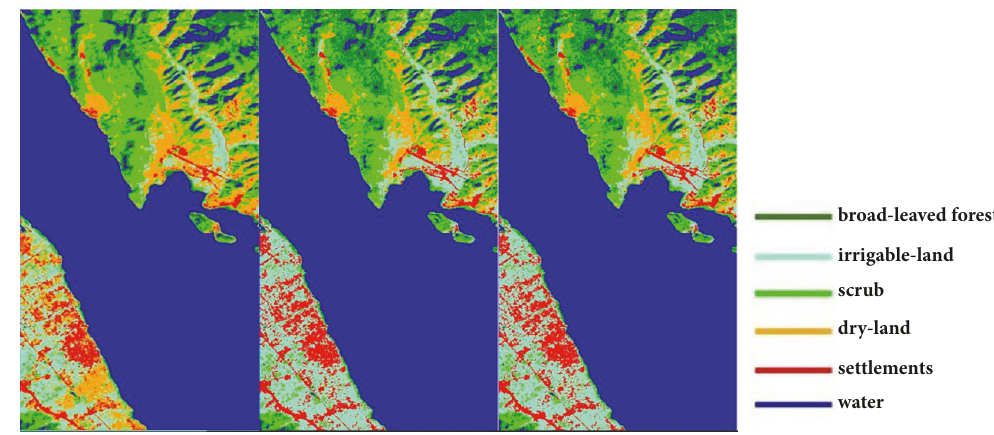
Figure 21: The classification results of support vector machine algorithm for the Hyperion data.